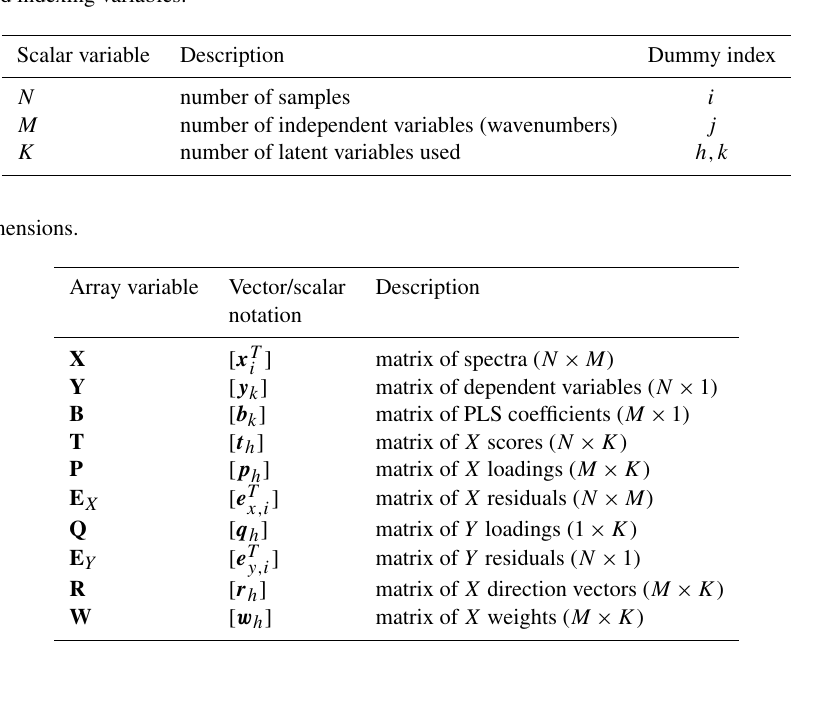
Table A1. Dimensions and indexing variables.